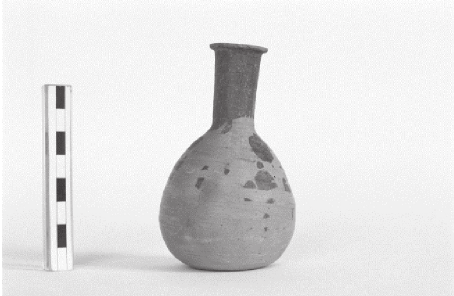
Figure 5: Unguentaria (ASCSA #BW 1976 029 28). © American School of Classical